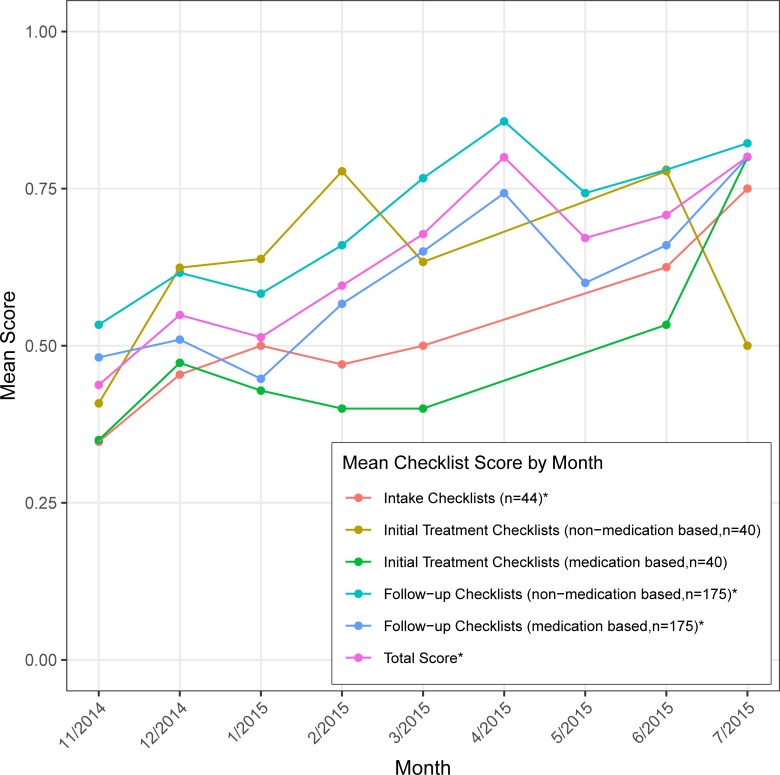
Mean checklist score by month.Dots indicate months in which checklist items were completed. Categories in the legend marked with an asterisk (*) showed significant improvement over nine months, all p<0.001 except Intake Score for which p = 0.002.